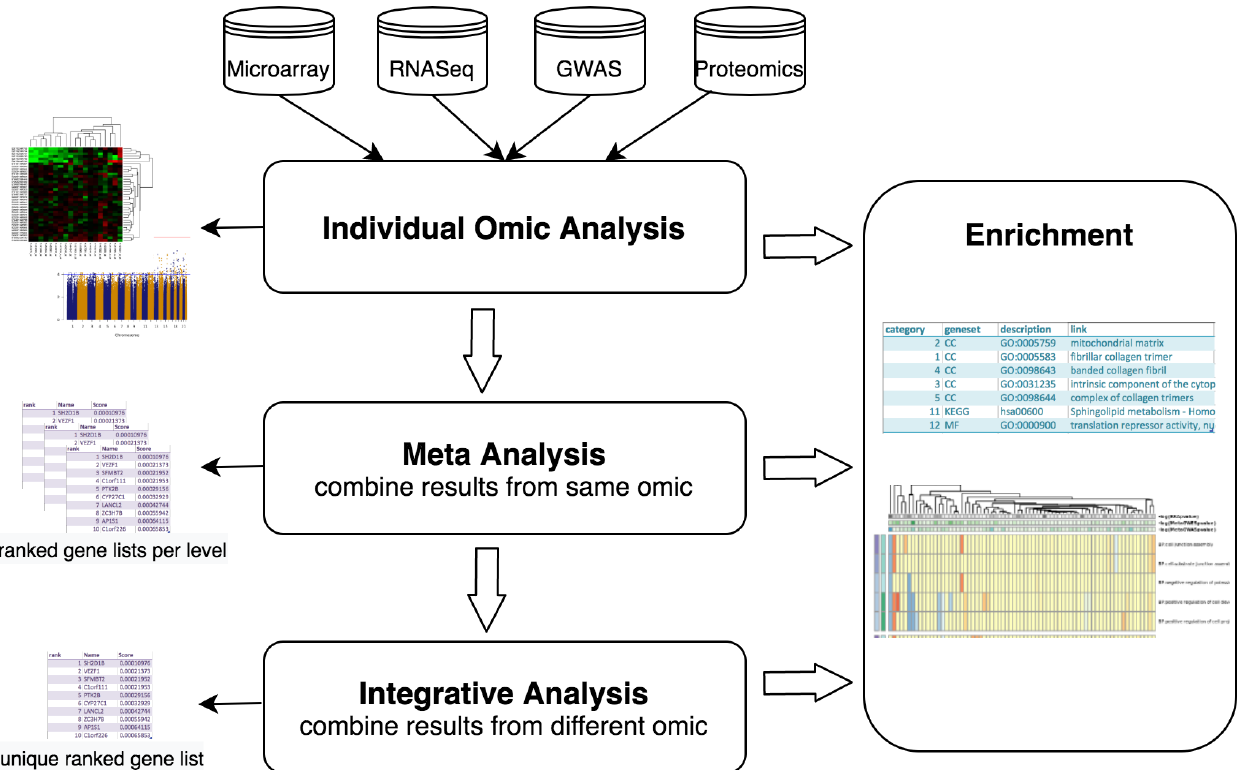
Figure 1. MOMIC pipeline